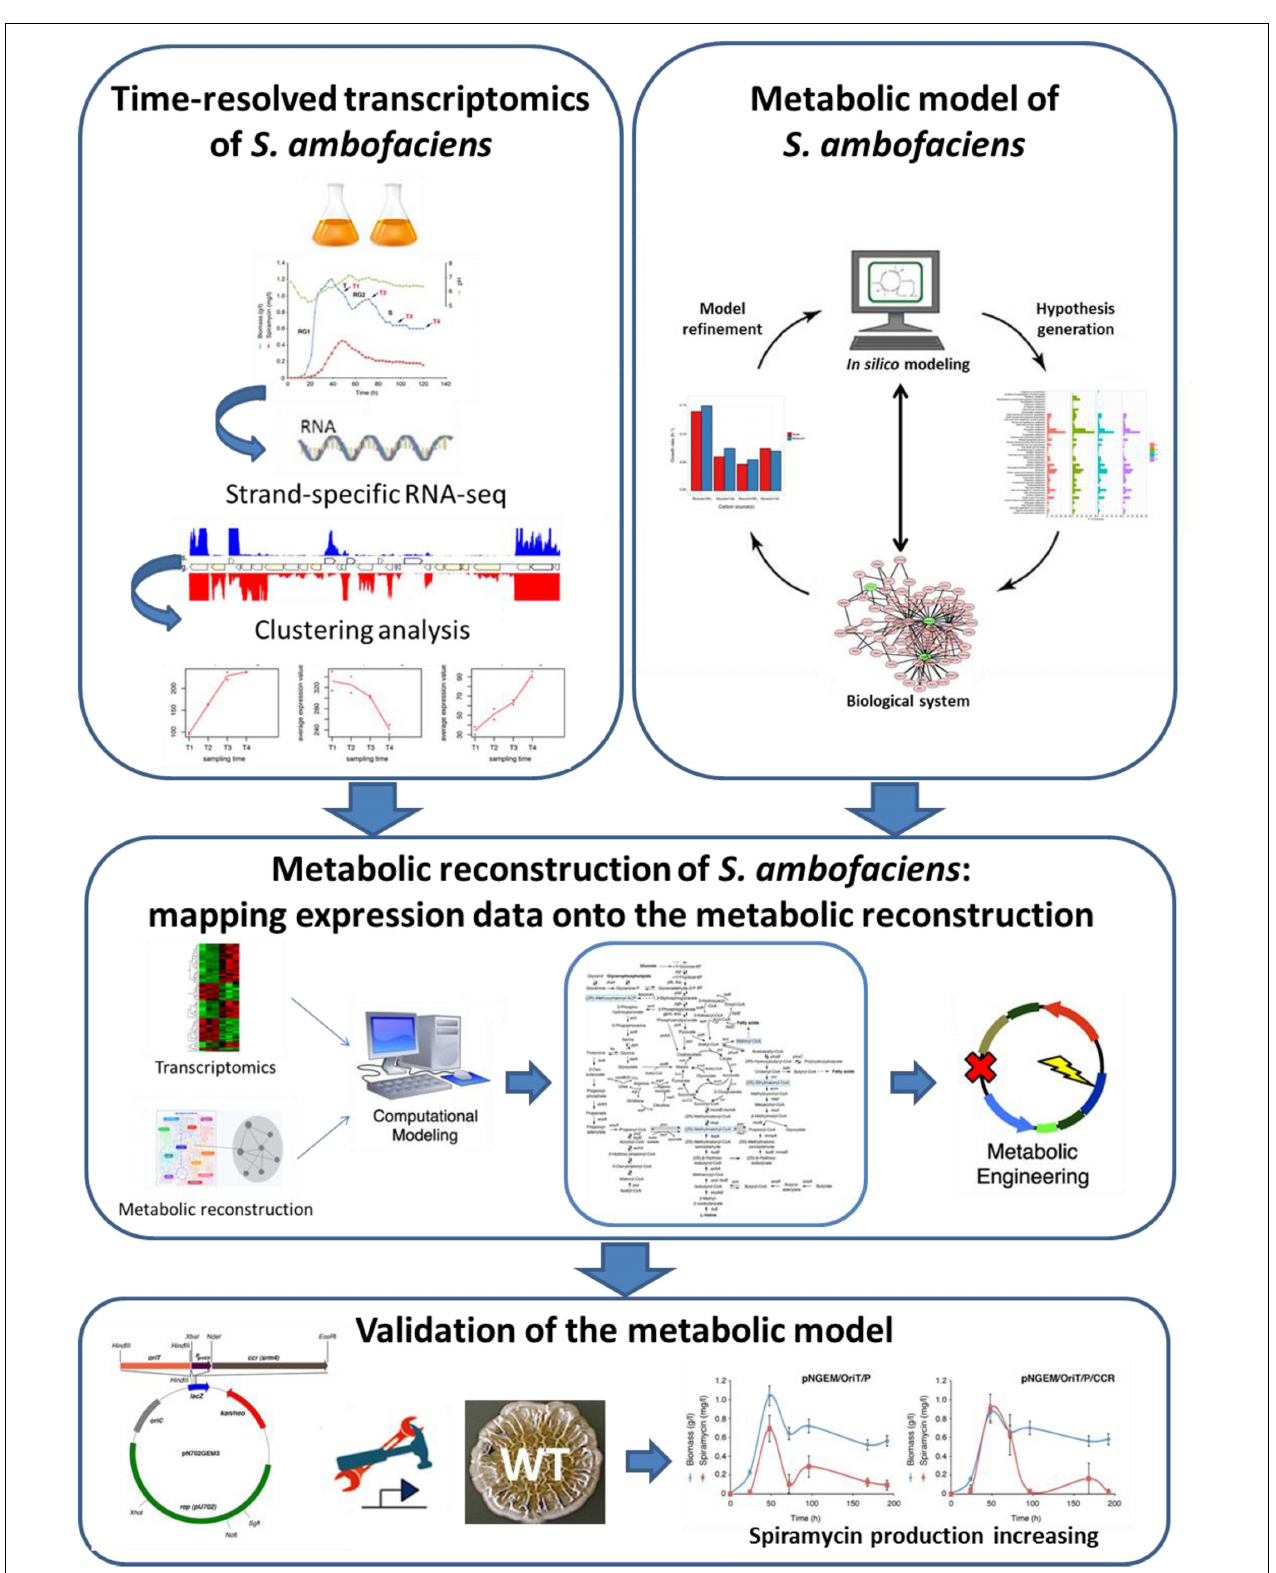
FIGURE 6 | Schematic representation of the integrated approach Workflow herein proposed.